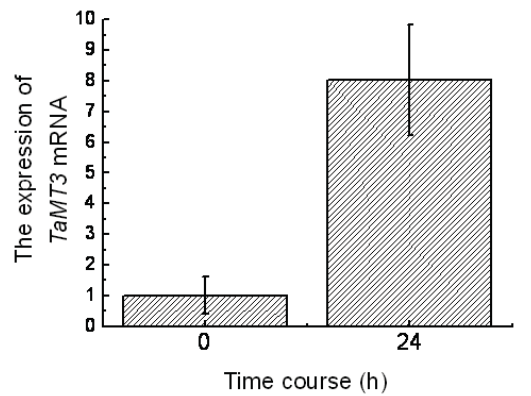
Figure 2. The expression of TaMT3 mRNA detected by reverse transcription quantitative polymerase chain reaction